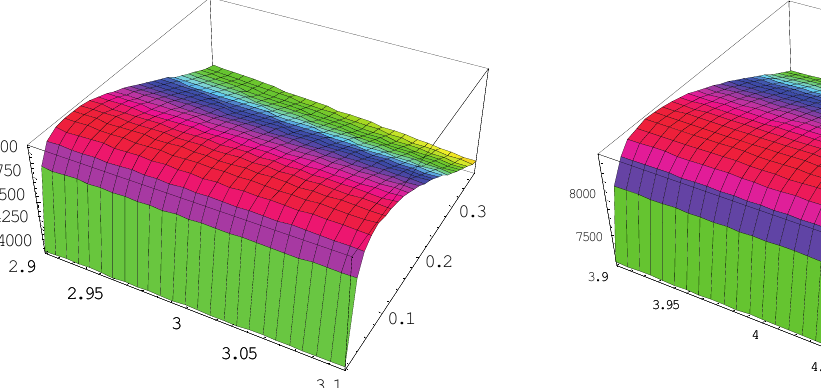
Fig. 4. Concavity of (cid:1846)(cid:1827)(cid:1842) ∗ for first item Fig. 5. Concavity of (cid:1846)(cid:1827)(cid:1842) ∗ for second